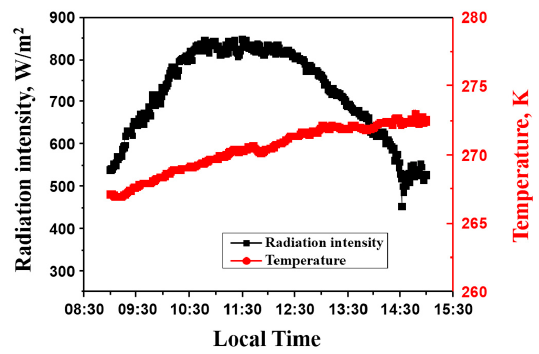
Figure 5. Variation of radiation intensity and outdoor air temperature during the